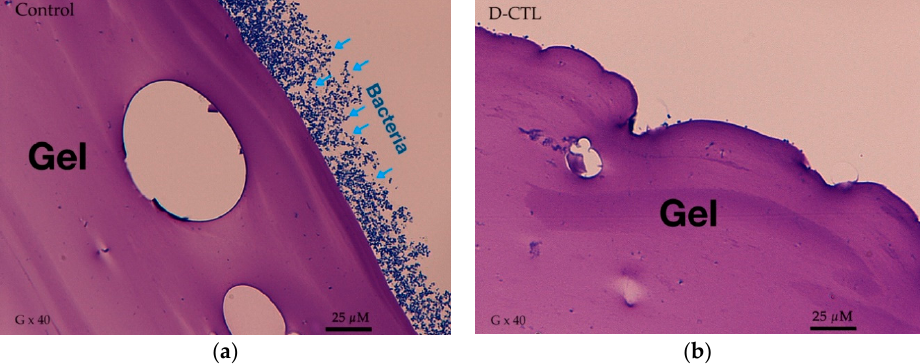
Figure 5. Alg–Cat 1% without/with antimicrobial agent and P. gingivalis (optical microscope view). ( a ) Gel without antibacterial agent is recovered by bacteria at the surface at 24 h ( b ) when D-CTL is added inside the gel, no bacteria are observed, showing an antibacterial effect.